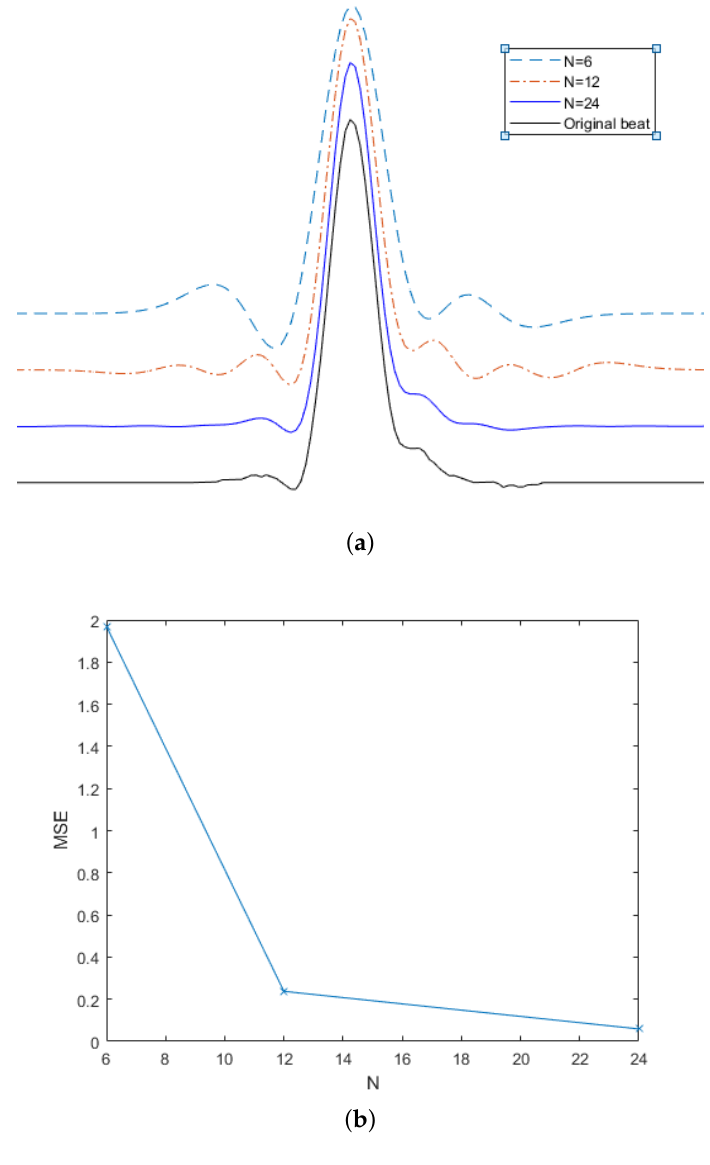
Figure 2. Effect of polynomial order in the quality of the estimation of one heartbeat ( N ∈ { 6,12,24 } ): ( a ) original heartbeat and different estimations; ( b )